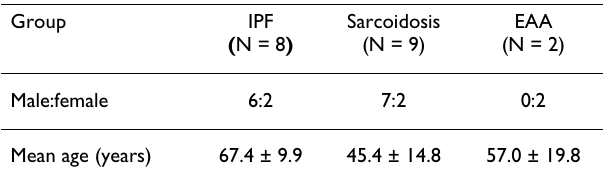
Table 1: Patient group demographics